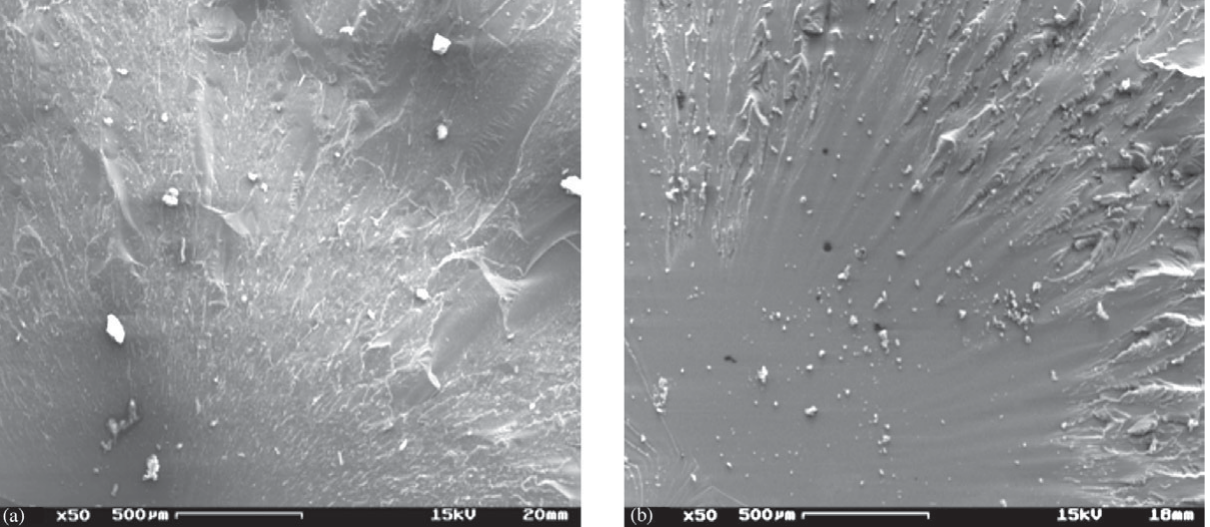
Figure 5. Fracture surface aspects. a) Common fracture surface for the brittle epoxy rich mixtures showing a small and not well defined mirror zone. Micrograph taken from a specimen of the 7 phr formulation; b) The fracture surface of the amine rich formulations domi- nated by a very large mirror zone. Micrograph from a 21 phr